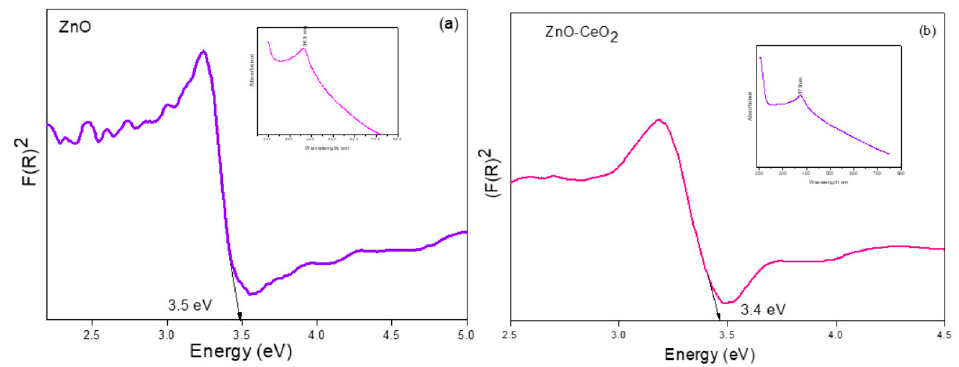
Figure 6. Band gap plots of ( a ) ZnO NPs (inset DRS graph) and ( b ) the CeO 2 -ZnO (inset DRS graph)